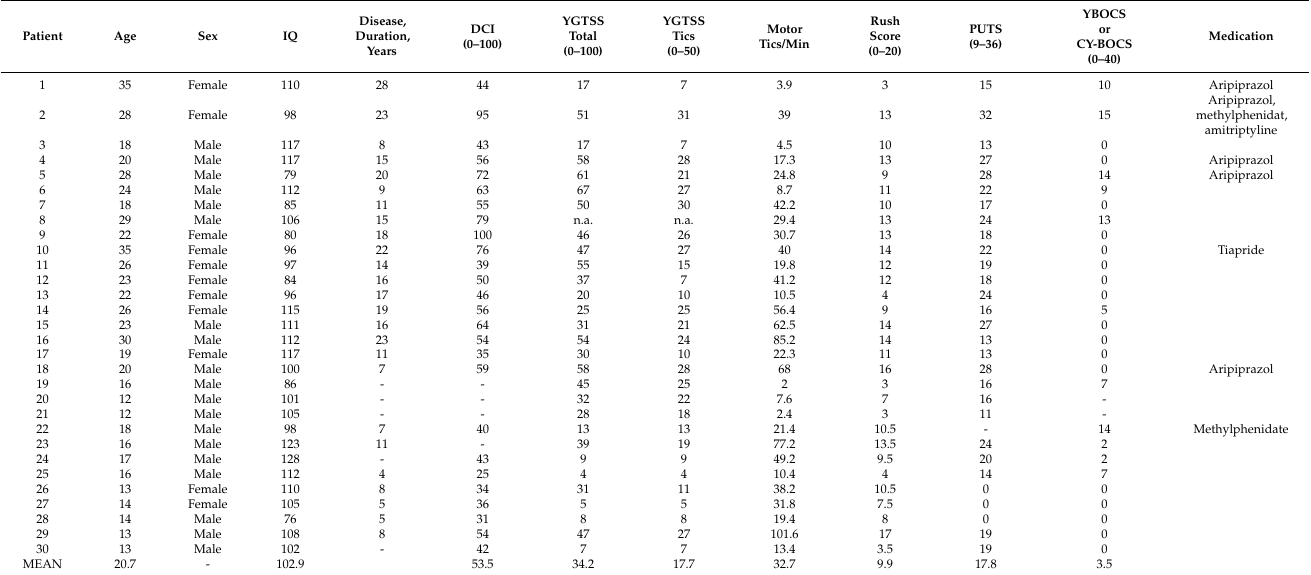
Table 1. Clinical characteristics of the patients with GTS included in the